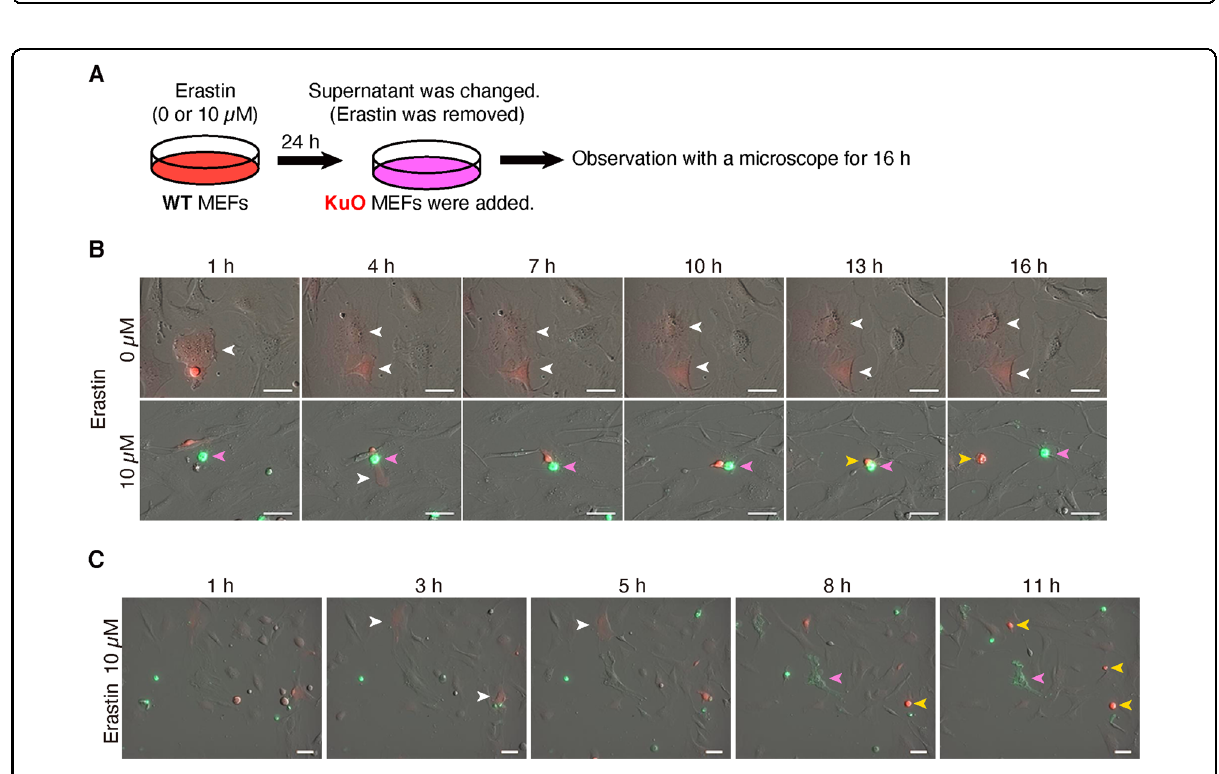
Fig. 6 Cell deaths propagated from ferroptotic cells to other cells. A – C After WT MEFs had been exposed to erastin, the supernatant medium was exchanged (erastin was removed). At that time, KuO mice-derived MEFs were added and cells were observed by fl uorescent microscope for 16 h. A Experimental outline. B , C Merged image of optical and fl uorescent (Red: KuO, Green: FITC-Annexin V) channel. B , C are from separate experiments. White arrowheads: alive KuO MEFs. Pink arrowheads: dead WT MEFs. Yellow arrowheads: dead KuO MEFs. Scale bars represent 50